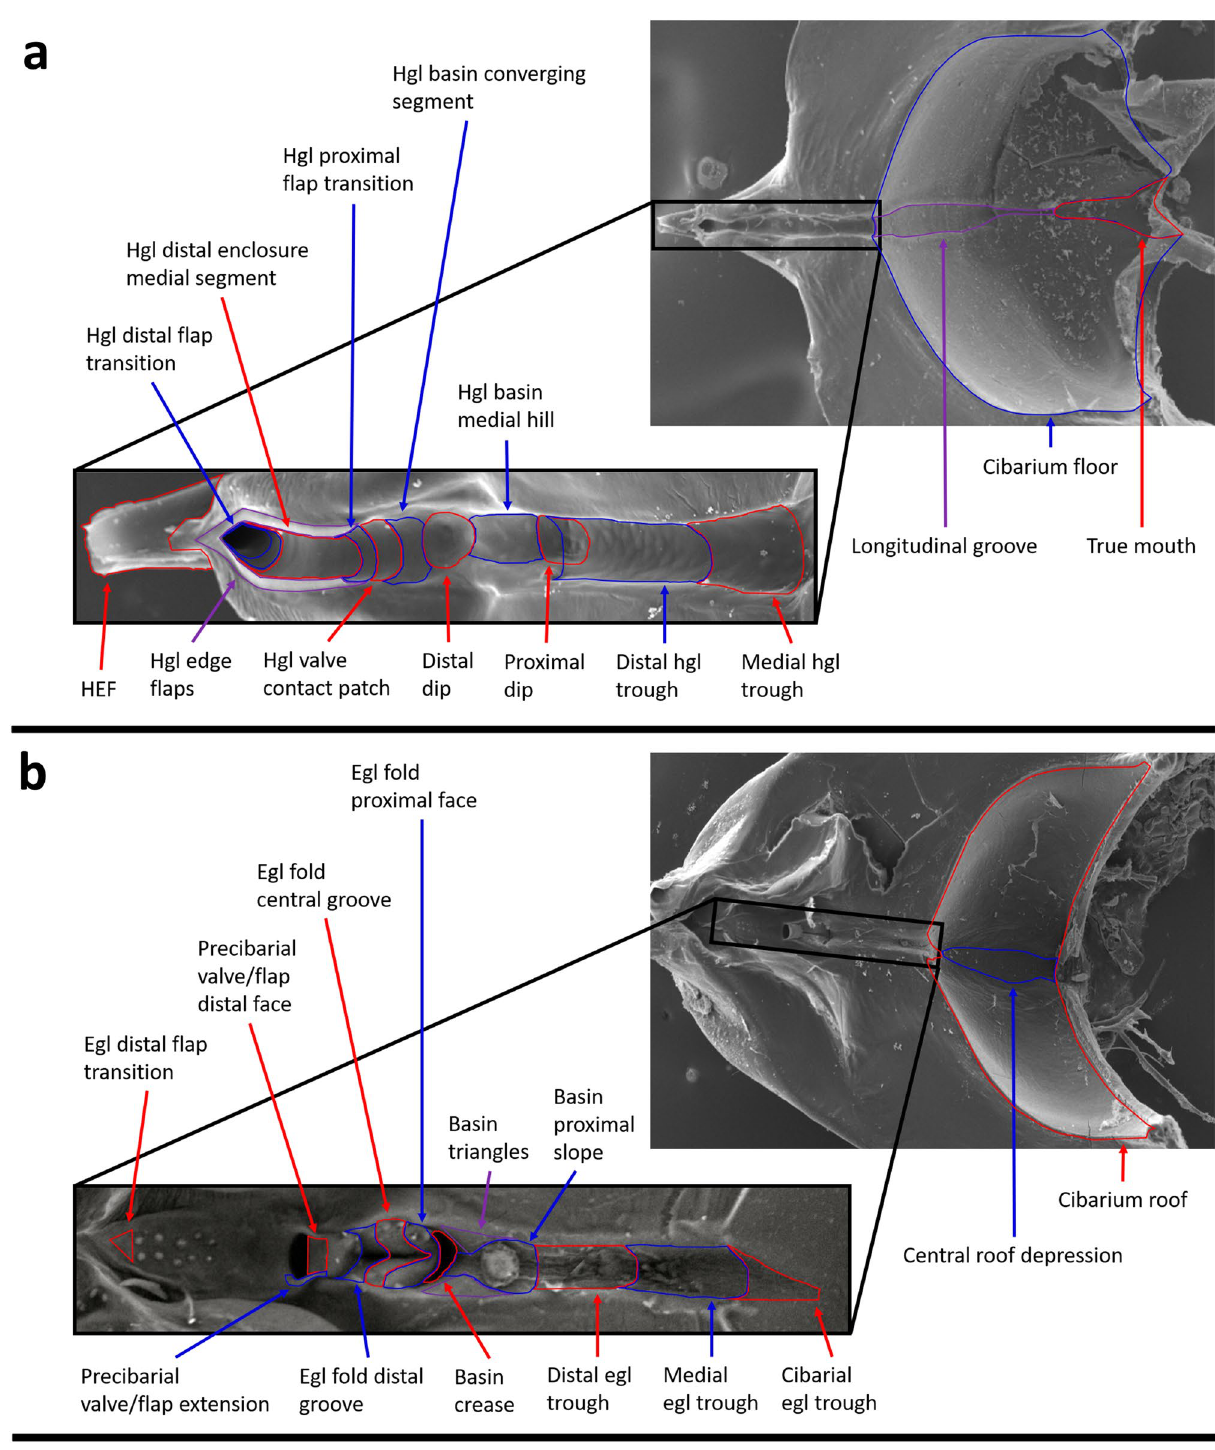
Figure 5. Fine resolution terminology for the precibarium and cibarium of the blue–green sharpshooter, labeled using scanning electron micrographs. ( a ) Hypopharynx. The electron microscope image on the top right was adapted from a previous publication (Reprinted with permission from Rapicavoli et al. 2015; copyright © American Society for Microbiology, [Appl. Environ. Microbiol. 81, no. 23 (2015): 8145–8154 10.1128/ AEM.02383–15]). ( b ) Epipharynx. hgl: hypopharyngeal; egl: epipharyngeal; HEF: hypopharyngeal extension that inserts into the stylet food